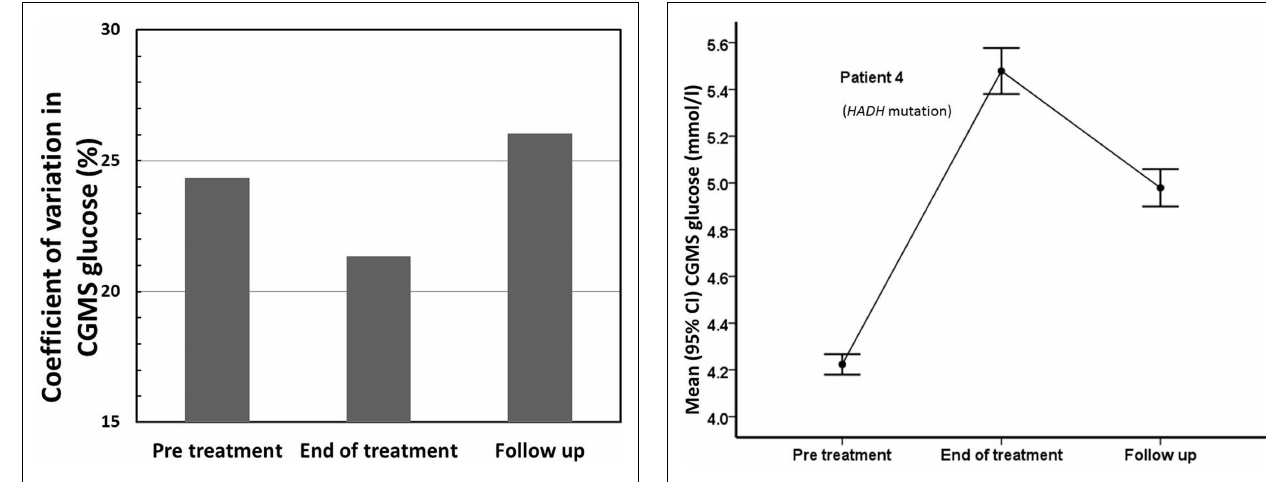
FIGURE 3 | Coefficient of variation (CV) (%) in CGMS glucose levels shows a reduction at the end of treatment in intention to treat analysis, indicating reduced variability in glucose profiles following treatment with PUFA .